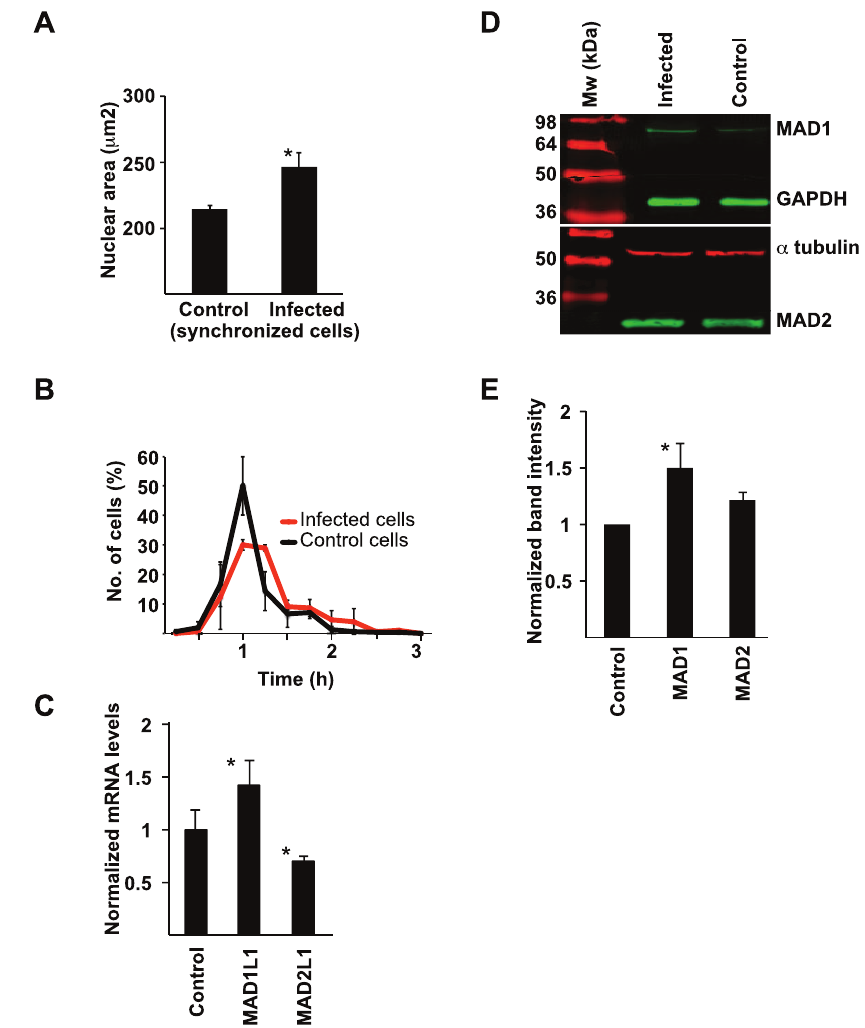
Figure 5. Gonococcal infection causes durations of mitosis, nuclear swelling, and targets regulatory mitotic genes and proteins. A. VK2/E6E7 cells were synchronized and bacteria were allowed to adhere and invade cells for 24 h. Cells were then fixed and stained with DAPI. The nuclear area of 300 infected and 300 uninfected cells were measured. Data were analyzed using a paired 2-tailed Student’s t -test. The average nuclear areas observed in 3 independent experiments are shown (* p , 0.05). Error bars represent S.E.M. B. Cells were infected with N. gonorrhoeae and observed for 24 h by live-cell microscopy. DIC images were captured every 15 min at randomly selected positions, and times spent transitioning from prophase to cytokinesis were measured for 150 mitotic cells. The graph shows mean ¡ standard deviation values for the time required for progression from prophase to cytokinesis, measured in 3 independent experiments. C. VK2/ E6E7 cells were infected with N. gonorrhoeae for 24 h. RNA from control cells and infected cells was isolated and qPCR was performed. Average mRNA levels of MAD1L1 and MAD2L1 from 3 independent experiments are shown (* p , 0.05). Error bars represent S.E.M. Values were normalized against TUBA1A expression and analyzed using a paired 2-tailed Student’s t -test. D. Protein expression in infected cells and control cells was analyzed in western blots using antibodies against of MAD1 and MAD2. GAPDH or a -tubulin was used as loading controls. E. Western blot band intensities were quantified and analyzed with a paired 2-tailed Student’s t -test, using GAPDH or a -tubulin expression as controls. Mean expression levels of each protein observed in 3 independent western blots are shown (* p , 0.05). Error bars represent